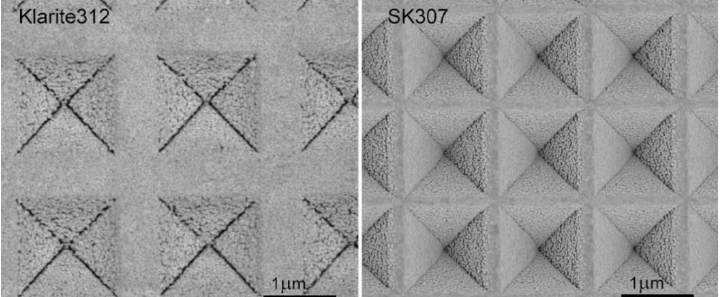
Figure 2. SEM images of the SERS substrates Klarite 312 and SK307. The images were obtained with scanning electron microscope Magellan (FEI, Hillsboro, OR, USA; TLD; 1–2 kV; 6.3–25 pA;